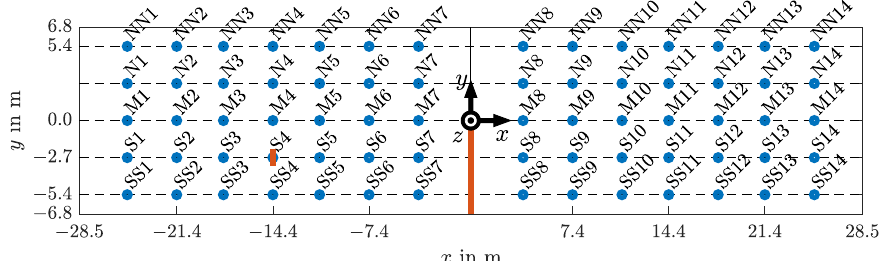
Figure 8. Bridge floor plan with node and element positions (blue points) of the simulated crossings for the Dietersdorf bridge and their names. The dotted lines indicate the beams. At the blue points, the strain in the x direction and the displacement in the z direction is available. The measurement direction corresponds to the coordinate system in the centre of the picture. The damage locations are marked in